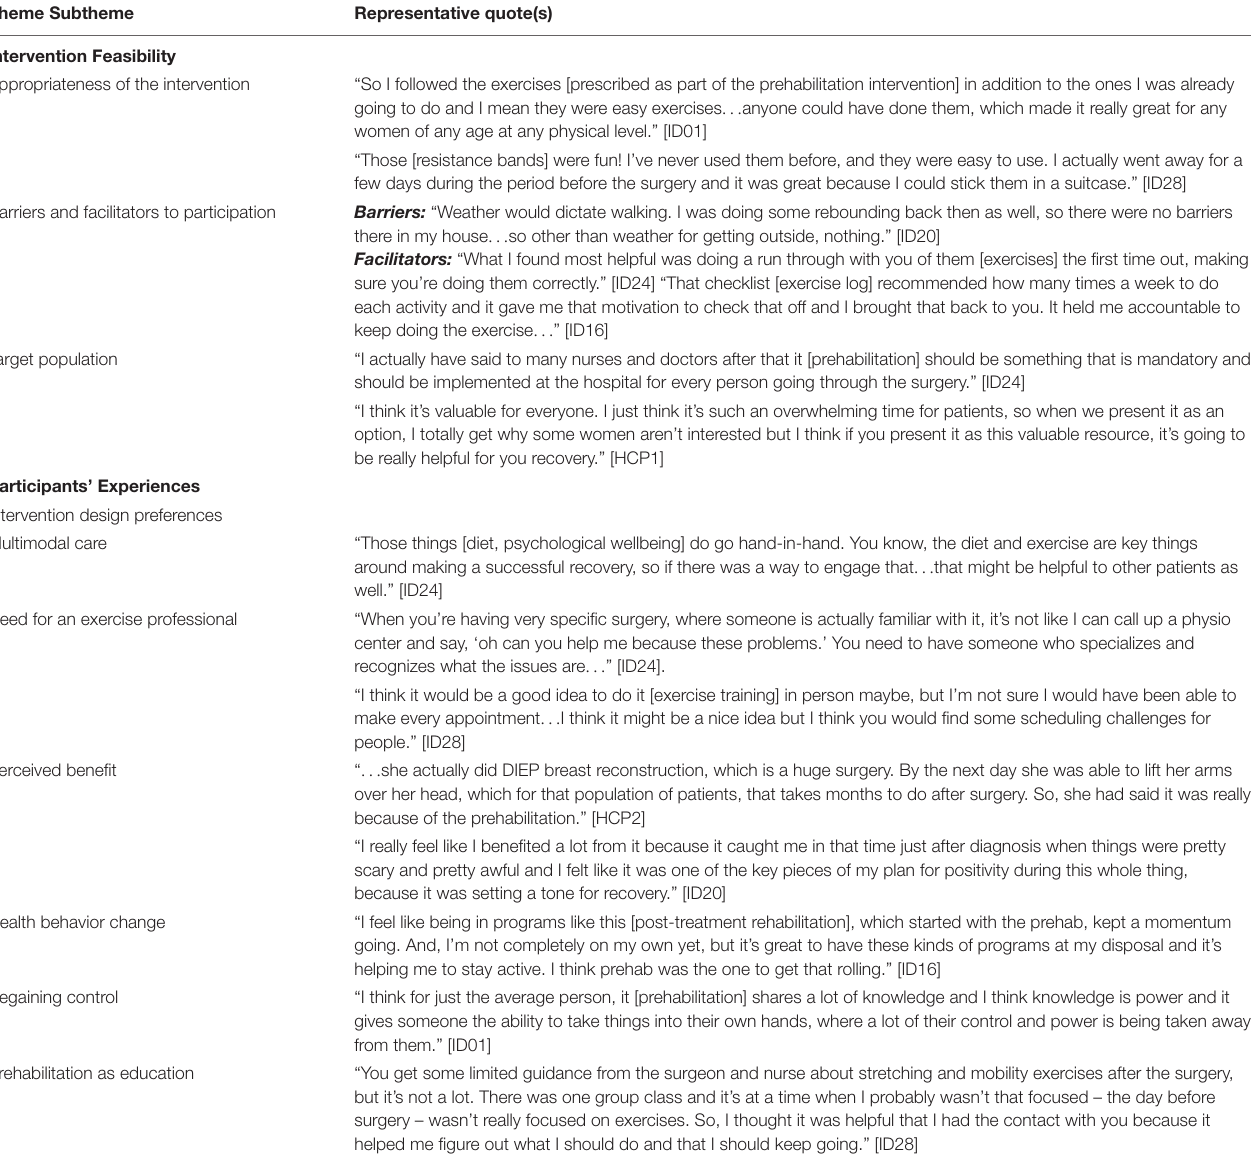
TABLE 4 | Selected quotes from participant and health care provider